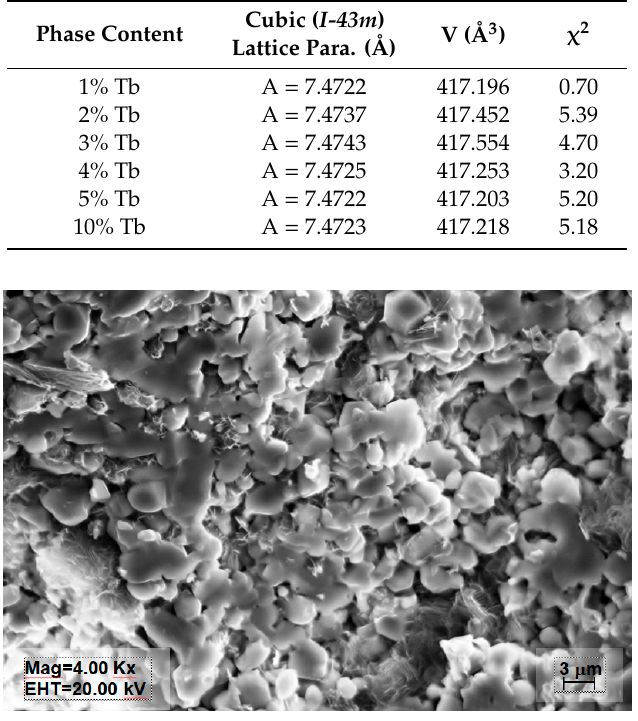
Figure 2. SEM micrographs of ZnB 2 O 4 :0.03Tb 3+ . Table 2. The atomic ratios of the ZnB 2 O 4 :0.03 Tb 3+ obtained from the EDX results. Zn/O